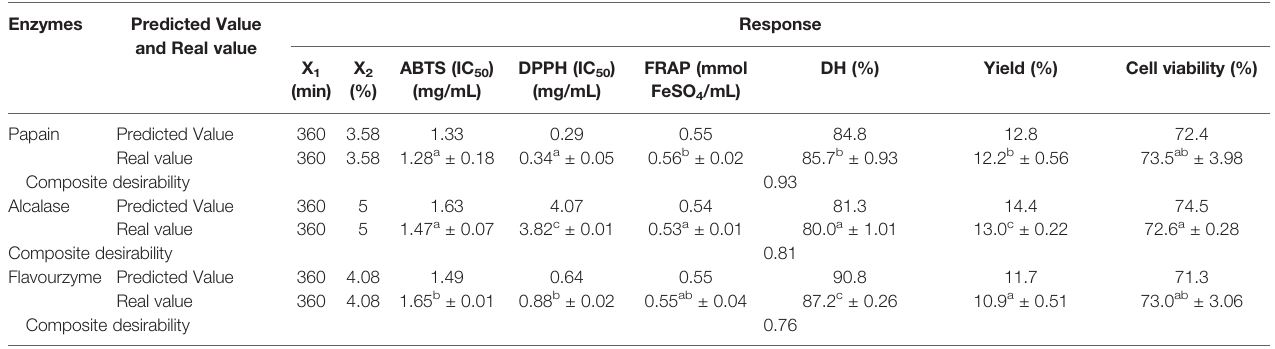
TABLE 5 | The optimize condition, predicted and experiment values from the model veri fi cation for all responses of sea cucumber hydrolysates using papain, alcalase, and fl avourzyme. Enzymes